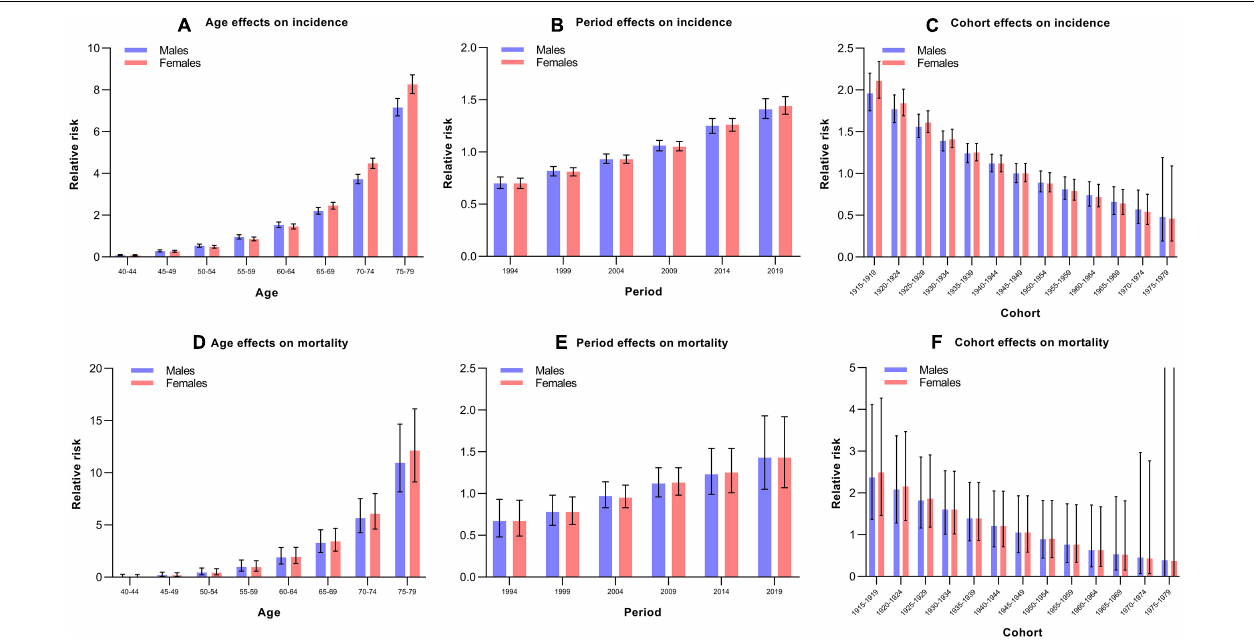
FIGURE 3 | Relative risks of the incidence of and mortality due to Alzheimer’s disease and other forms of dementia in China from 1990 to 2019 due to age, period, and cohort effects. (A) Age effects on incidence; (B) Period effects on incidence; (C) Cohort effects on incidence; (D) Age effects on mortality; (E) Period effects on mortality; (F) Cohort effects on